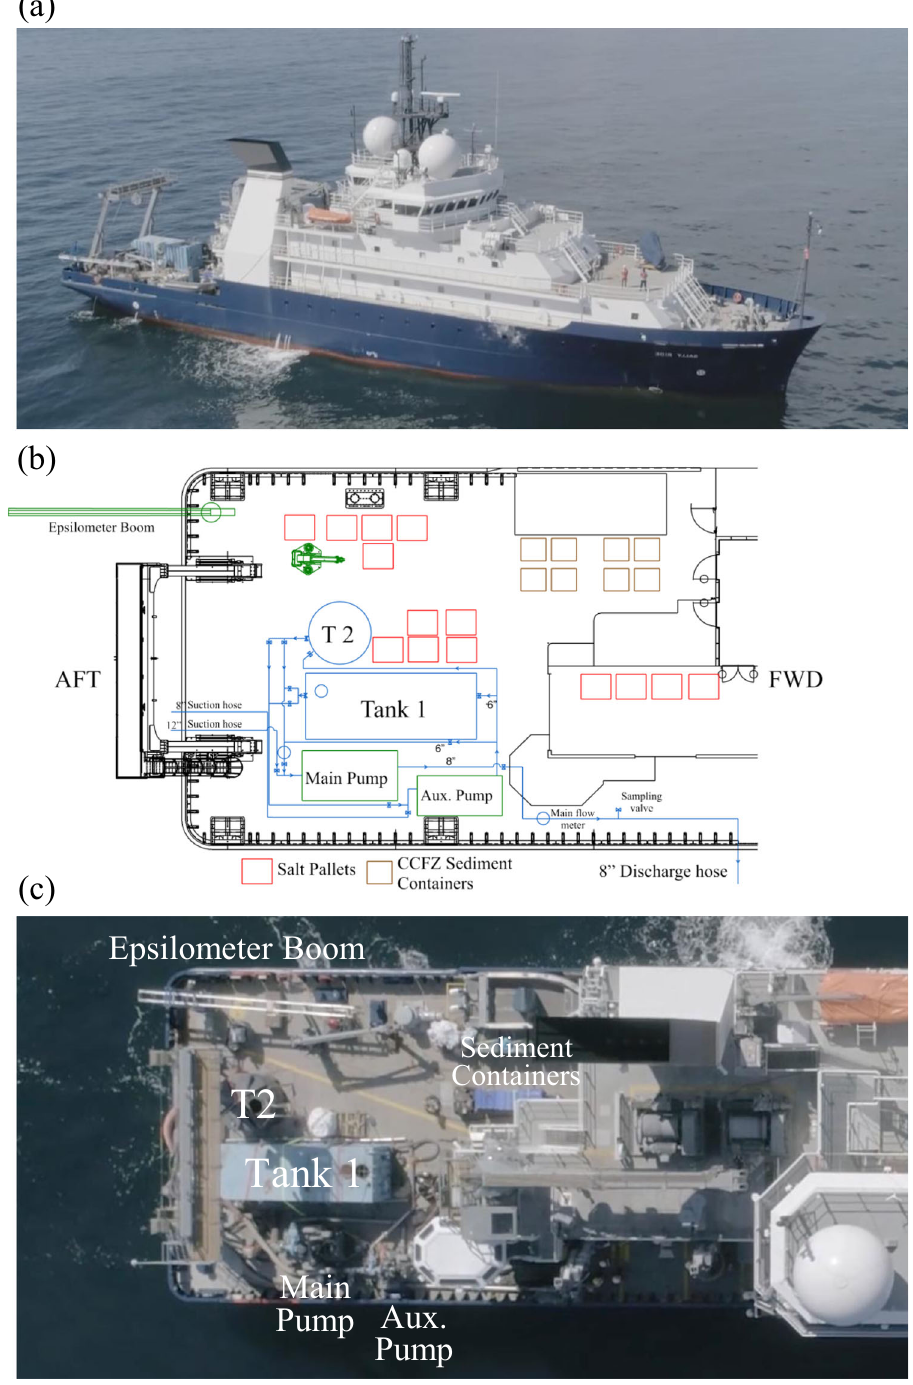
Fig. 8 Plume creation system. a The R/V Sally Ride during PLUMEX fi eld studies. b Schematic of the aft main deck where the plume creation equipment was installed. Red squares correspond to the location of the salt bags used to increase the initial density of the salt water plumes. Brown squares indicate the location of the totes with the mixture of salt water and CCFZ sediment. The epsilometer was deployed from the epsilometer boom (in green). c A top view of the main deck with some key items had three independent optic sensors with the capability of working at three dif- mounted on the epsilometer. As the ocean current advected the plume, the ferent wavelengths: 670 nm for turbidity, 570 nm for Rhodamine dye concentra- orientation of the vessel was set based on the current direction measured by the tion, and 650nm for chlorophyll. The sensors were calibrated for each plume shipboard ADCP, so that both the discharge hose and the epsilometer were aligned discharge using a water sample of the actual plume, obtained from the discharge with the current heading. line. Each sample was diluted and measured with the sensors several times until reaching dilution factors up to 50,000, which was close to the lower detection Scattering fl uorescence and turbidity sensor . The ECO Triplet (Sea-Bird Scienti fi c) threshold of the sensor (Supplementary Fig. 13). scattering fl uorescence sensors mounted on the epsilometer and the CTD rosette